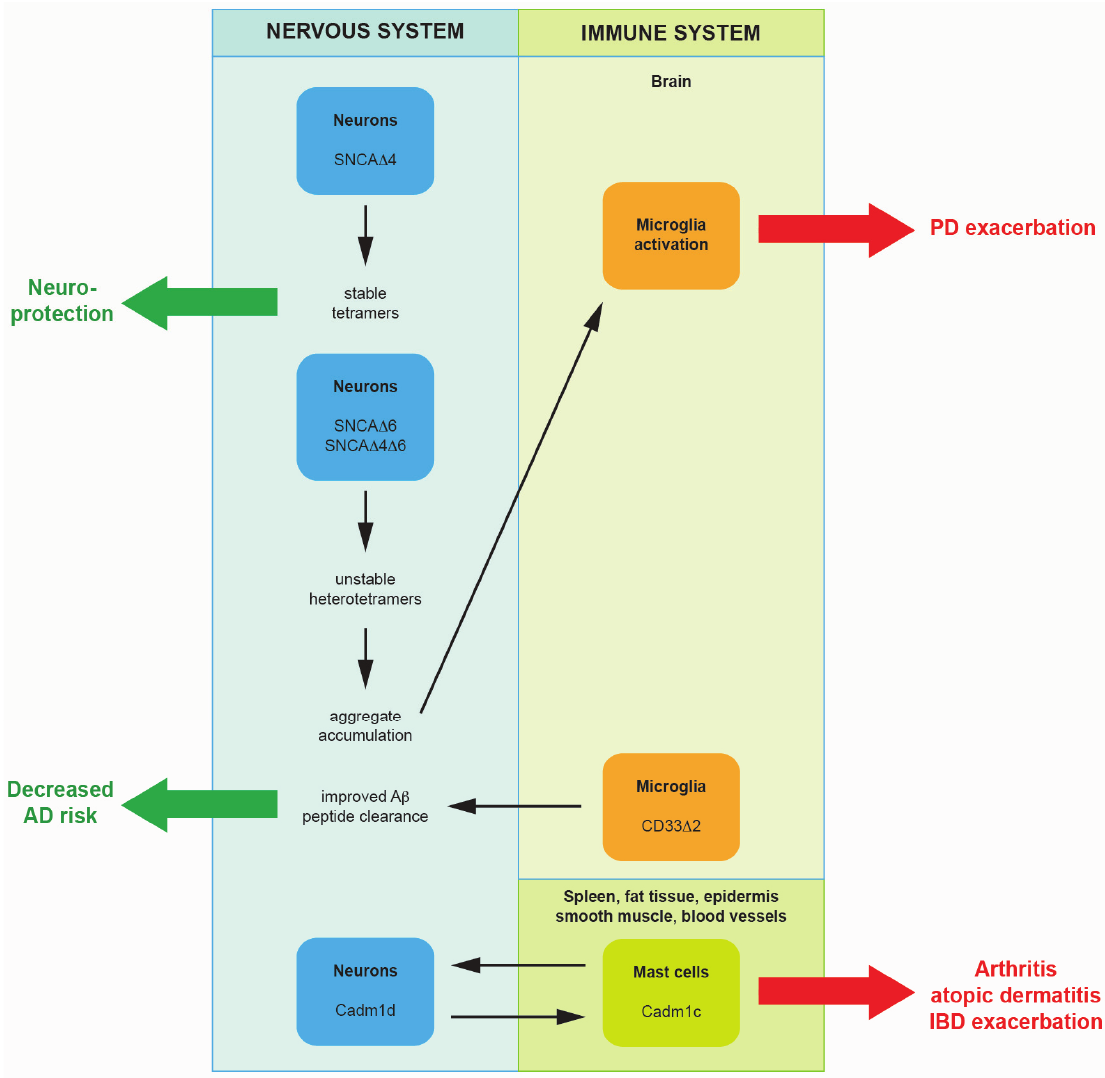
Figure 1. Scheme illustrating the interaction between the nervous and immune systems during inflammation via alternatively spliced isoforms of SNCA, CD33 and